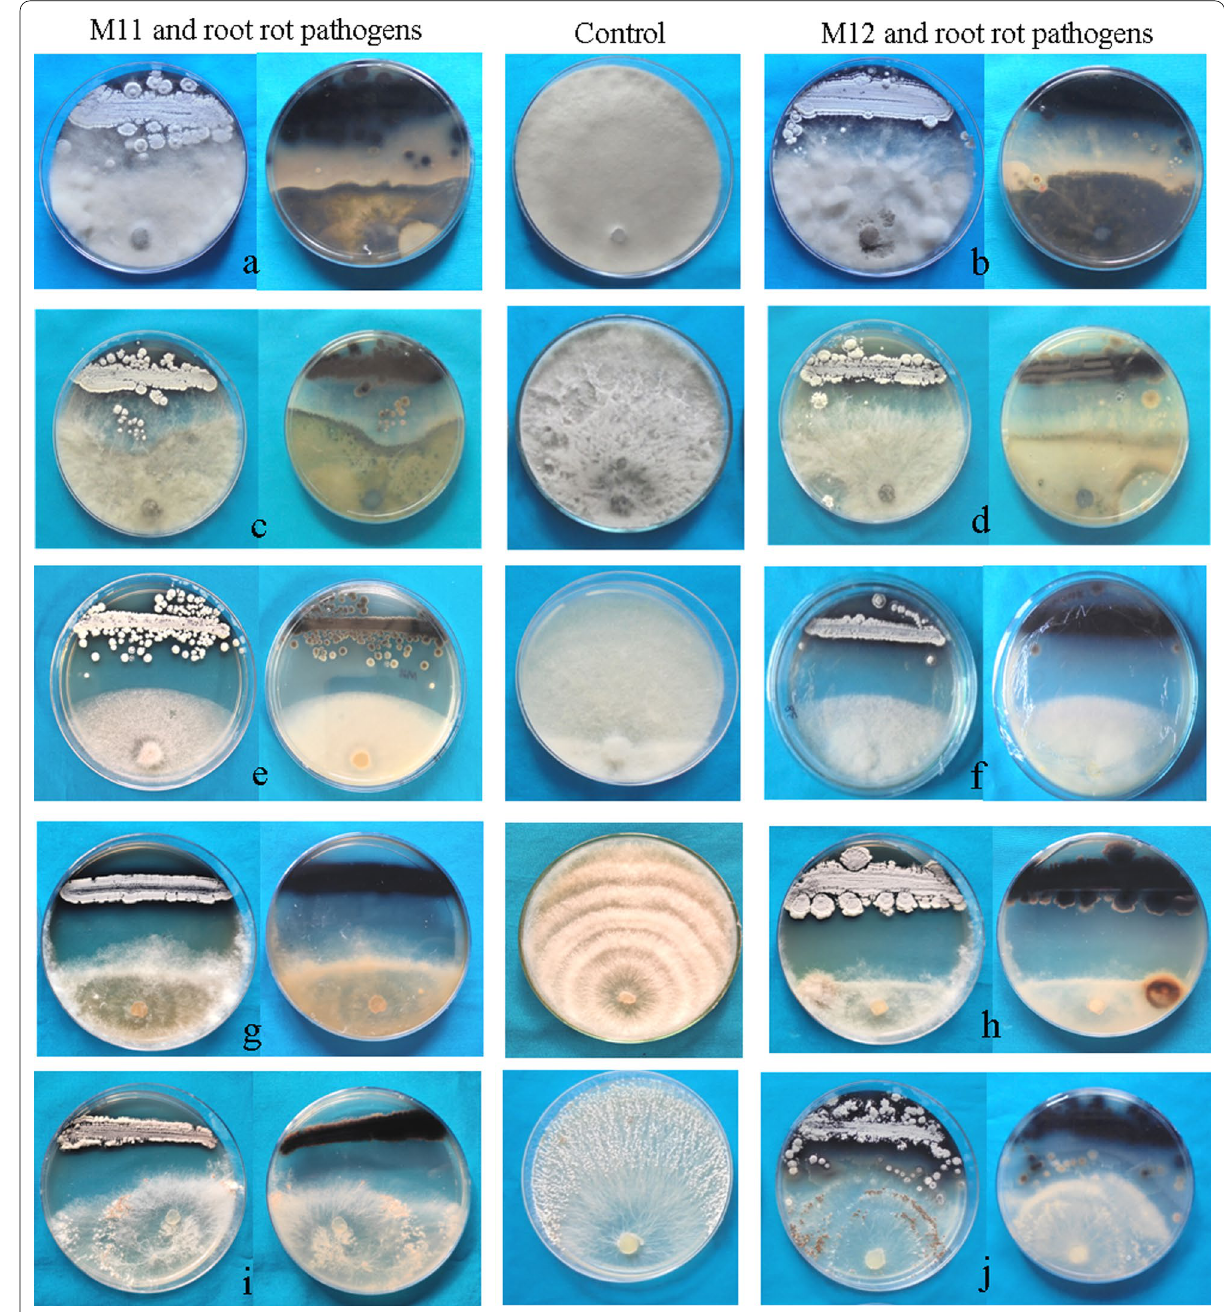
Fig. 2 In-vitro screening of melanogenic actinobacteria against mulberry root rot pathogens. a b M11 and M12 versus Macrophomina phaseolina , c , d M11 and M12 versus Lasiodiplodia theobromae , e , f M11 and M12 versus Fusarium solani , g , h M11 and M12 versus Rhizoctonia solani ; i , j M11 and M12 versus Sclerotium